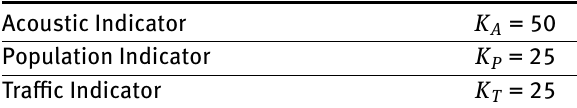
Table 1: Weighting factors for the Acoustic Quality Index Acoustic Indicator K A = 50 Population Indicator K P = 25 Traflc Indicator K T =